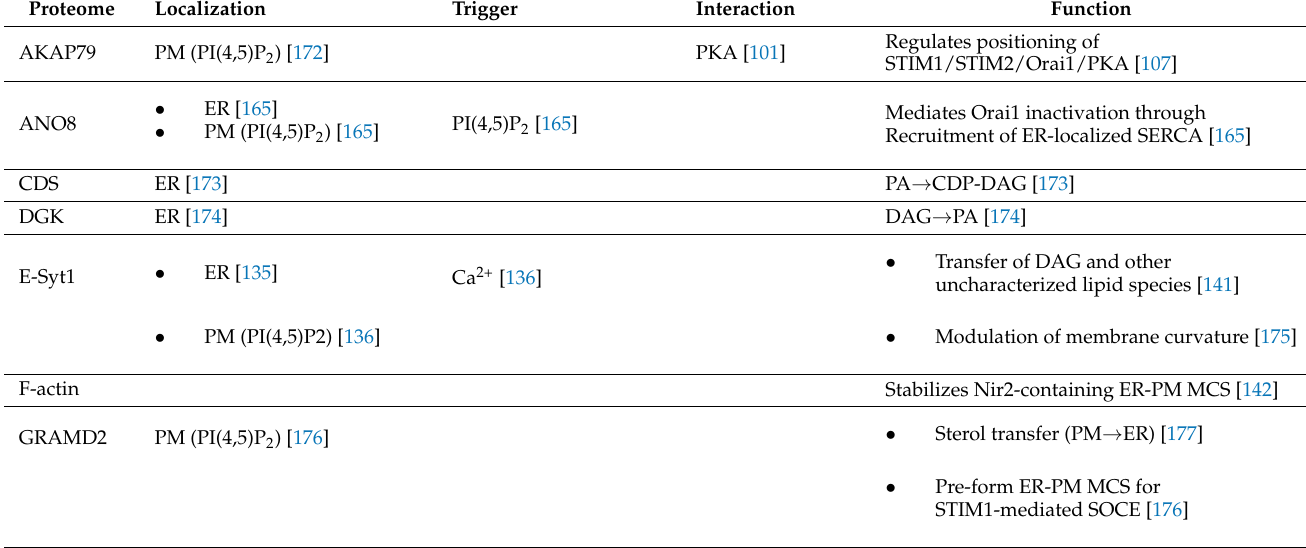
Table 1. Overview of ER–PM contact site-residing proteins. Abbreviations: AKAP79, A-kinase Anchor Protein 79; ANO8, Anoctamine-8; CDS, CDP-Diacylglycerol Synthase; DGK, Diacylglycerol Kinase; E-Syt1, Extended Synaptotagmin-1; GRAMd2, GRAM domain-containing protein 2; IP3 R , Inositol Triphosphate Receptor; Kv2, Delayed rectifier potassium channel; Nir2, Pyk2 N-terminal Domain-Interacting Receptor 2; Orai1, Calcium Release-Activated Calcium Channel Protein 1; ORP, Oxysterol-Binding Protein-Related Protein; PI4K, Phosphatidylinositol 4-kinase; PIP5K, Phosphatidyli- nositol 4-Phosphate 5-Kinase; Phosphatidylinositol Synthase; PKA, Protein Kinase A; PLC, Phospholipase C; Sac1, Phosphatidylinositol-3-Phosphatase; SARAF, Store-Operated Calcium Entry-Associated Regulatory Factor; SERCA, Sar- coplasmic/Endoplasmic Reticulum Calcium ATPase 3; STIM1, Stromal Interaction Molecule 1; TMEM24, Transmembrane Protein 24; TRPC1, Transient Receptor Potential Channel 1; VAP, Vesicle-Associated Membrane Protein-Associated